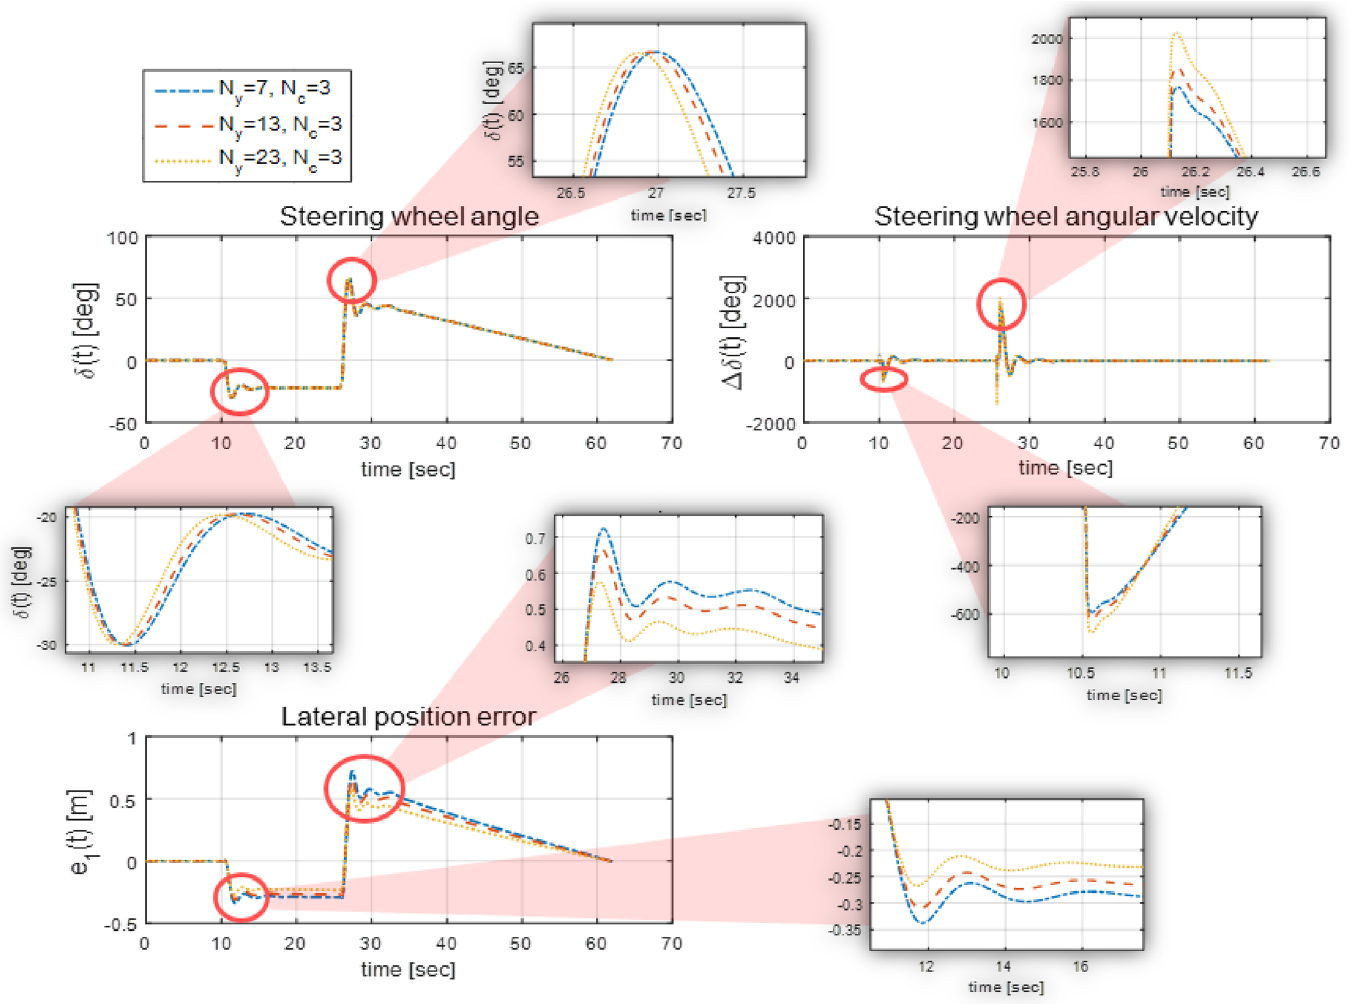
Fig 6. Simulation results with different ranges of prediction horizon. This figure shows the simulation results when the range of the prediction horizon N while the input horizon N u is fixed at 3. As N y increases, the input dynamics, i.e., the steering wheel angle, changes in advance; this consequently reduces the lateral position error because a longer N y improves the prediction ability of the controller. However, we found that an extremely long N y leads to an increase in the steering wheel angular velocity, which deteriorates ride